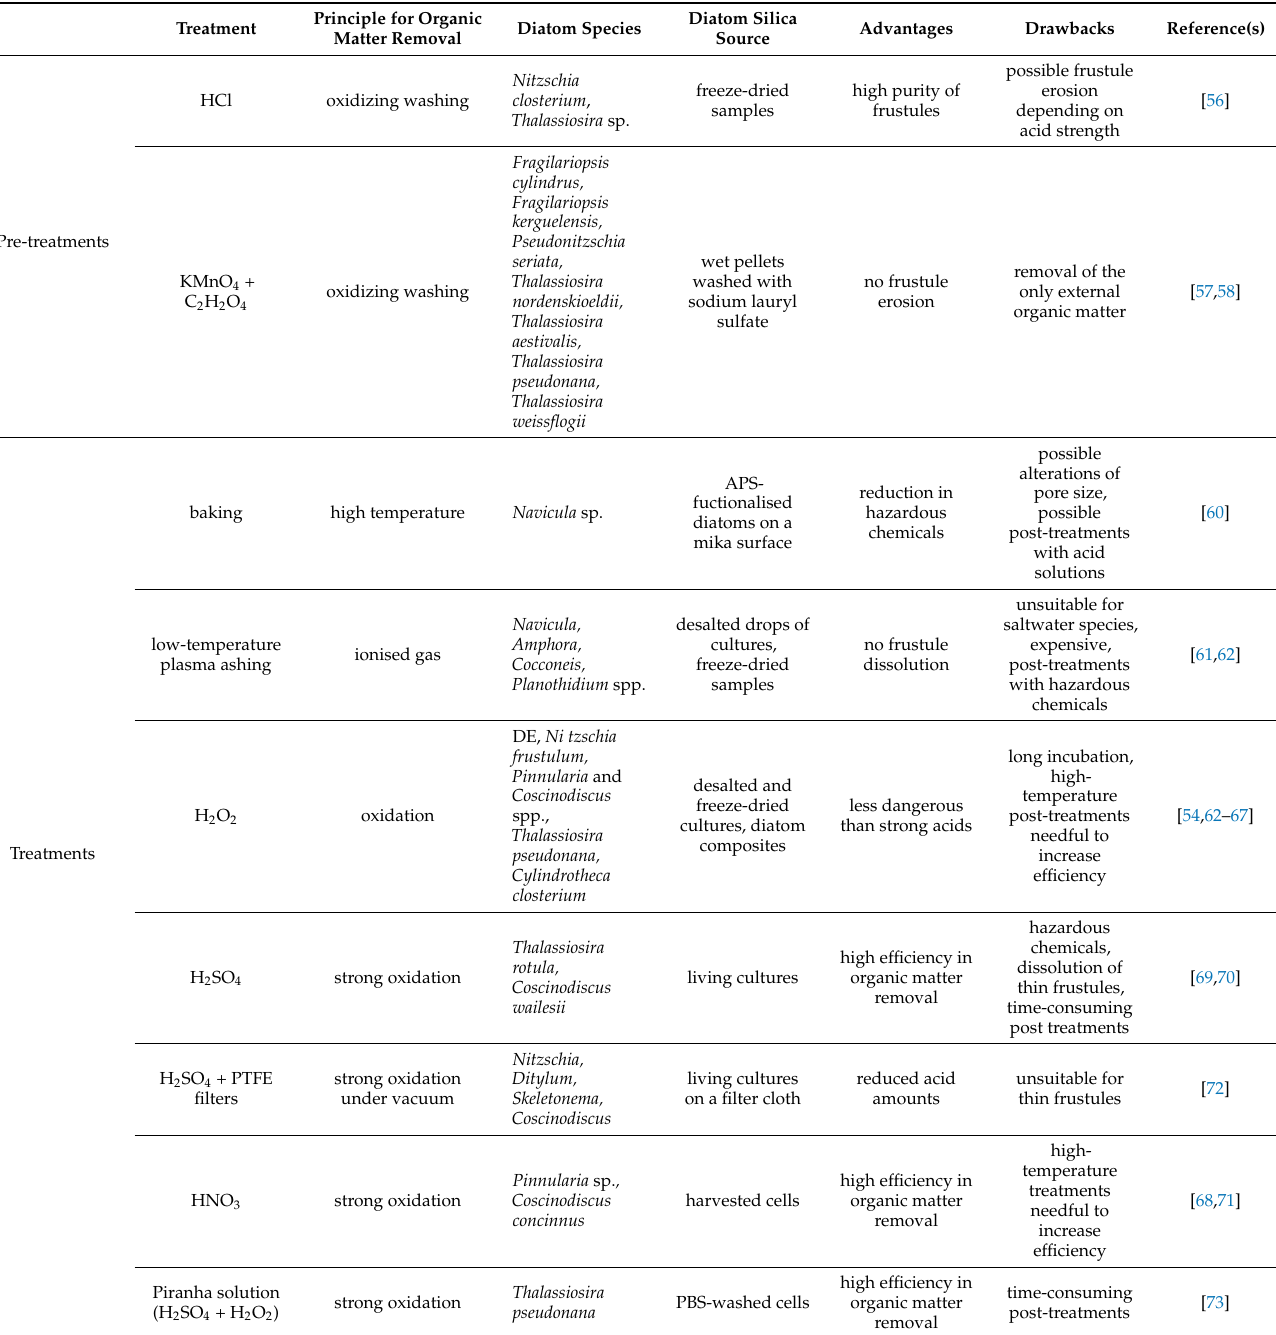
Table 1. Pre-treatments and treatments for diatom frustule cleaning and their main advantages and drawbacks.